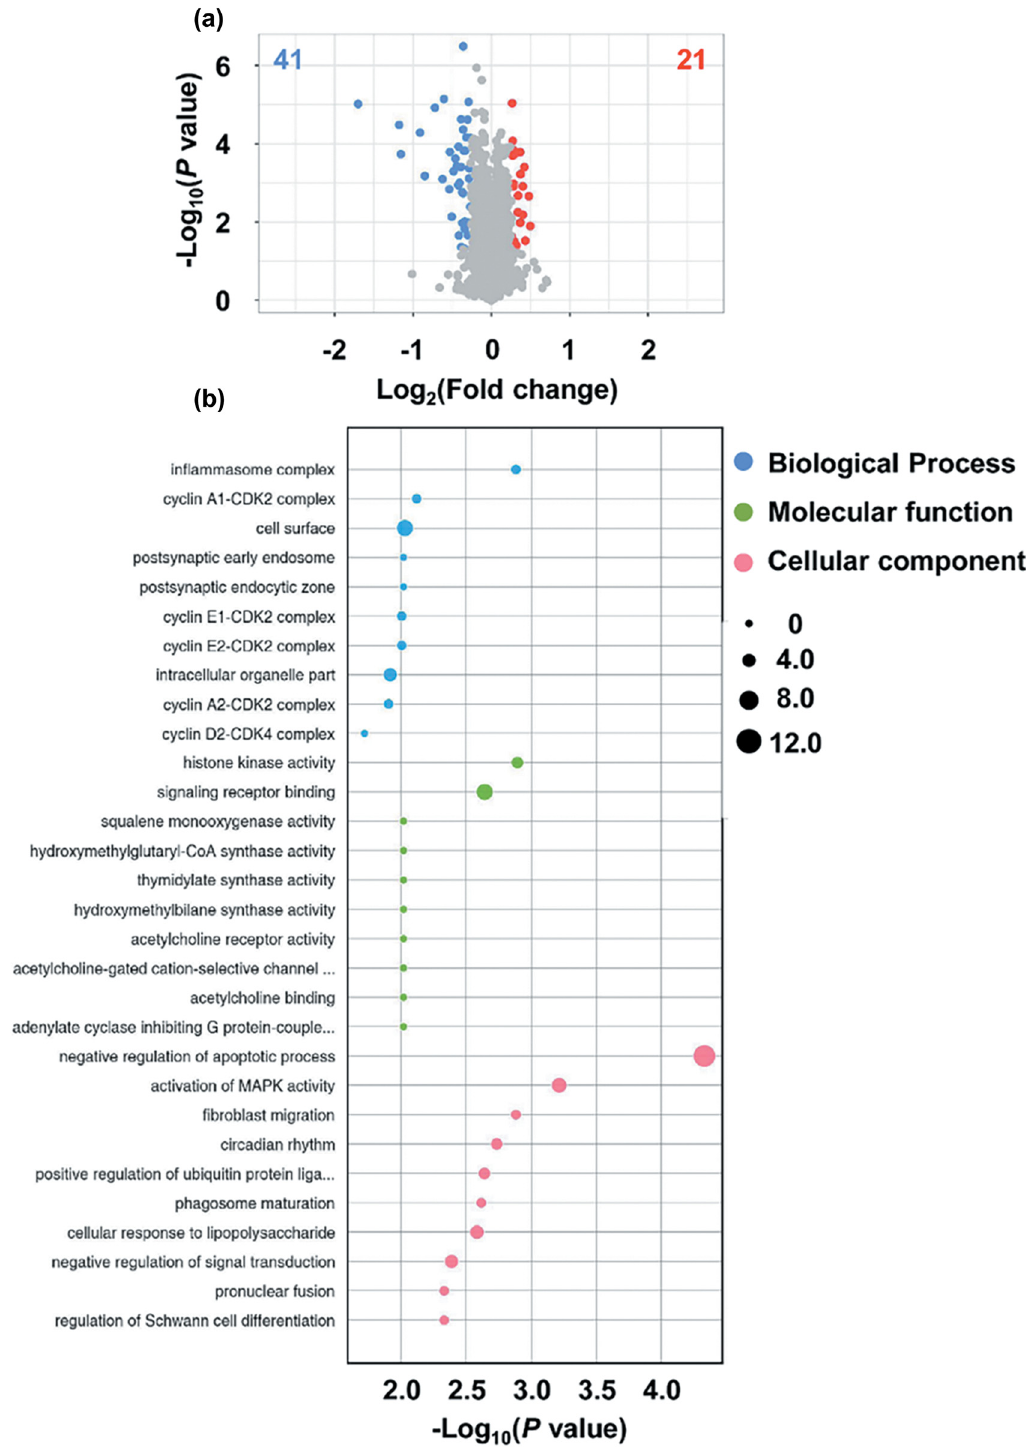
Figure 5: Comparative pro fi ling of the proteomes after downregulation of RBM17. ( a ) Volcano plots of the proteomes in LV - shRBM17 vs LV - scramble. ( b ) Bubble chart displaying GO terms for biological process and cellular components. GO terms were functionally grouped depending on Kappa scores and only the most signi fi cant GO terms were displayed. The signi fi cance of each GO term was displayed as − log10 ( P - value )